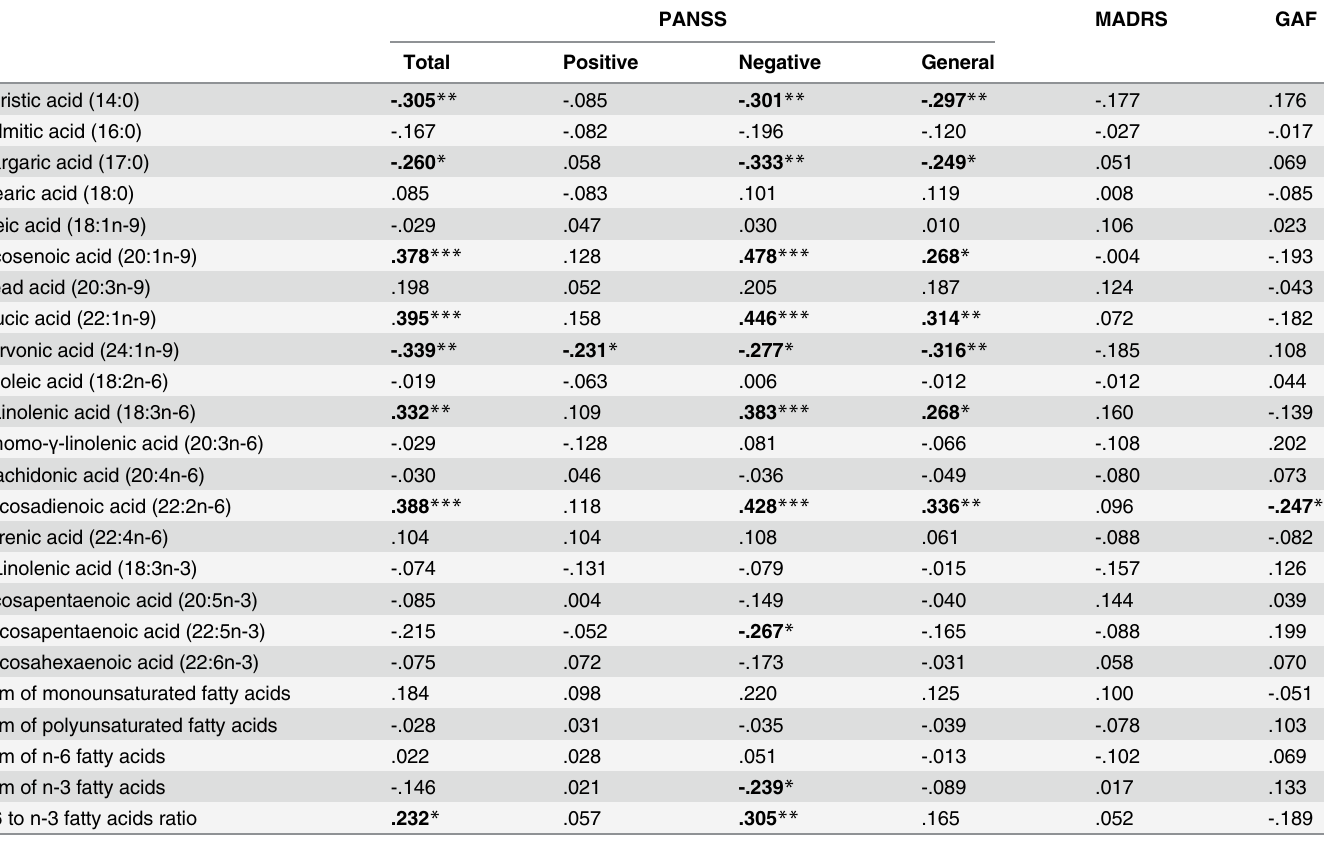
correlations were found with two saturated FAs (myristic and margaric acids) and one ω -9 MUFA (nervonic acid), whereas positive correlations were found with two ω -9 MUFAs (eico- senoic and erucic acids) and two ω -6 PUFAs ( γ -linolenic and docosadienoic acids). One ω -3 PUFA (docosapentaenoic acid, (DPA)) was negatively correlated with PANSS negative symp- toms scores. GAF scores were correlated with one ω -6 PUFA (docosadienoic acid). Demographic and clinical characteristics of subgroups according to PANSS scores are shown in Table 2. No significant differences were found with regard to age; sex; use of alcohol, cannabis, tobacco, or any illicit drug; MADRS scores; or transition to psychosis. GAF scores were significantly lower in the negative-symptoms-dominant group than in the positive-symp- toms-dominant group (p-value = 0.004, ANOVA post-hoc analysis). Table 3 include the results of group comparison of FA levels among the three PANSS sub- groups. The sum of ω -3 PUFAs and myristic acid levels were significantly lower in the nega- tive-symptoms-dominant group than in the positive-symptoms-dominant group. The sum of the ω -9 MUFAs and two single ω -9 MUFAs (eicosenoic and erucic acids), two ω -6 PUFAs ( γ